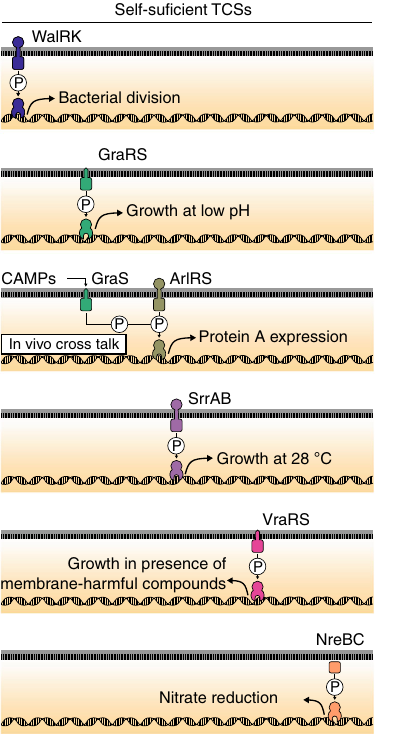
Fig. 4 Schematic summary of the S. aureus strains producing a single TCS to demonstrate functional self-suf fi ciency. WalRK regulates bacterial division, GraRS is necessary to grow at a low pH, ArlRS induces the expression of protein A in CDM, SrrAB allows adaptation to grow at 28 °C, VraRS controls the susceptibility to Triton X-100, and NreBC confers the capacity to reduce nitrate to nitrite. Moreover, GraS is able to phosphorylate ArlR, upon the presence of antimicrobial cationic peptides, such as colistin, and activates protein A expression